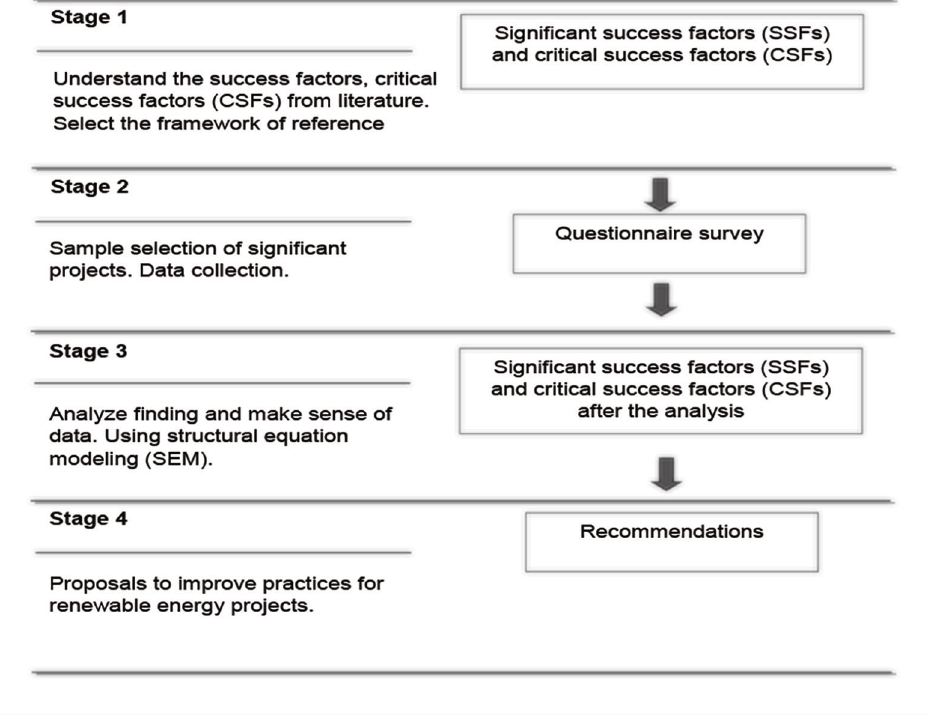
Figure 2. The research method